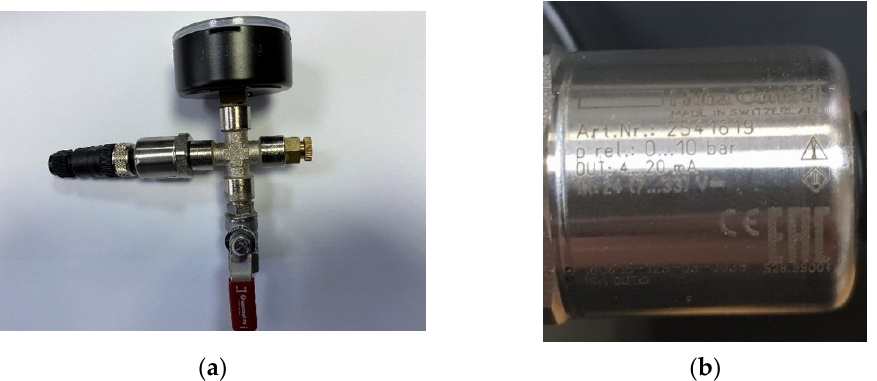
Figure 2. Huba Control sensor type: ( a ) overview image of the used sensor ensemble; ( b ) detailed view of our sensor.